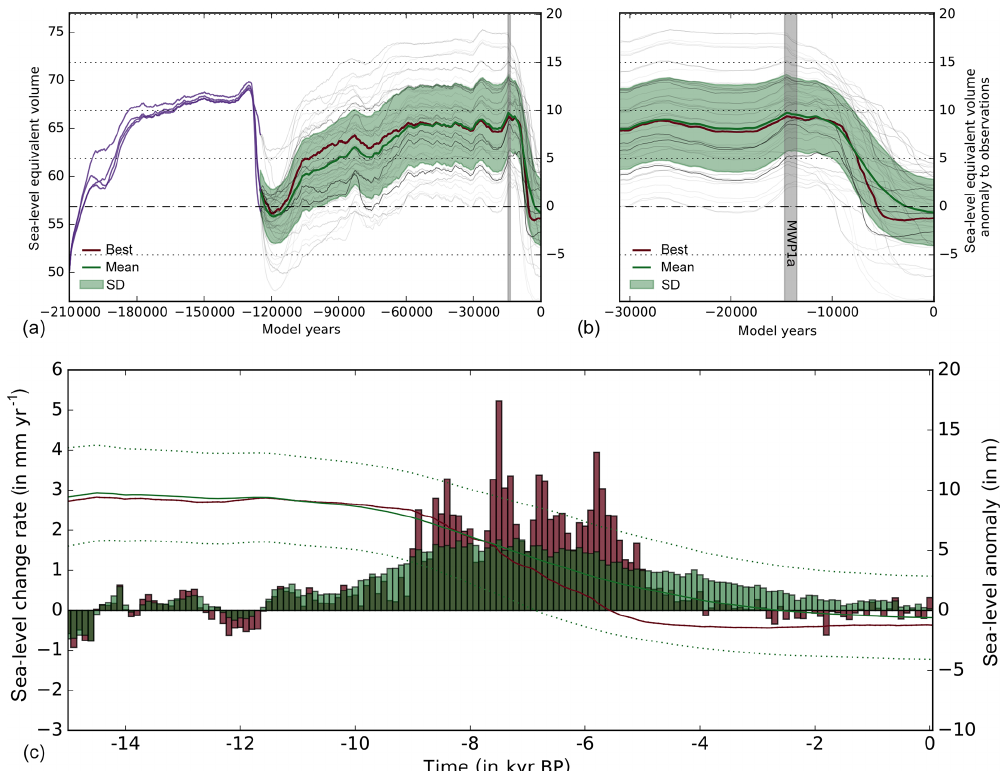
Figure 9. Simulated sea-level-relevant ice volume histories over the last two glacial cycles (a) and for last deglaciation (b) for all 256 indi- vidual runs of the parameter ensemble, transparency-weighted by aggregated score. Red line indicates the best-score run, and the green line and shading indicate the score-weighted ensemble mean and standard deviation, respectively. At Last Glacial Maximum (here at 15kyrBP) the reconstructed ensemble-mean ice volume above flotation yields 9.4 ± 4.1mSLE above present-day observation (compare to Figs. 5 and C4 in Pollard et al., 2016). Violet lines indicate simulations over the penultimate glacial cycle, with four different mantle viscosities which the full ensemble branches from at 125kyrBP. During deglaciation the score-weighted ensemble mean (green) shows most of the sea-level change rates (c) between 9 and 5kyrBP, with mean rates above 1mmyr − 1 , while the best-score simulation (red) reveals rates of sea-level rise of up to 5mmyr − 1 (100yr bins) in the same period (cf. Golledge et al., 2014, Fig. 3d). In contrast to the ensemble mean, the best-score member (red line) shows minimum ice volume in the mid-Holocene (around 4kyrBP) and subsequent regrowth.